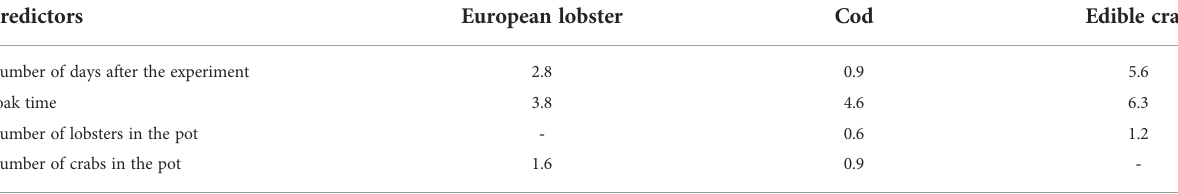
European lobster Cod